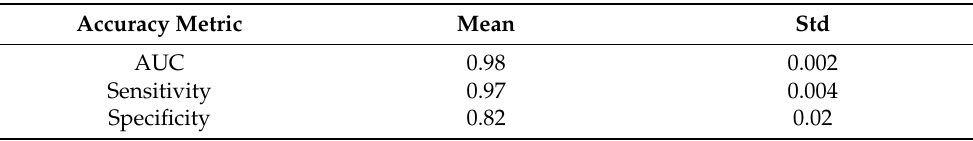
Table 6. The results of the predictions on the test cohort. (GUT: gastrointestinal tract).